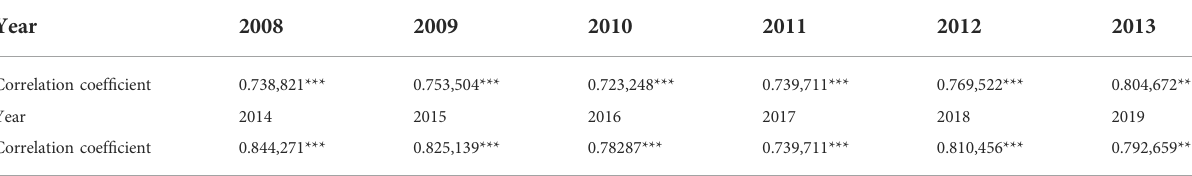
TABLE 3 Results of Spearman ’ s rank correlation test.